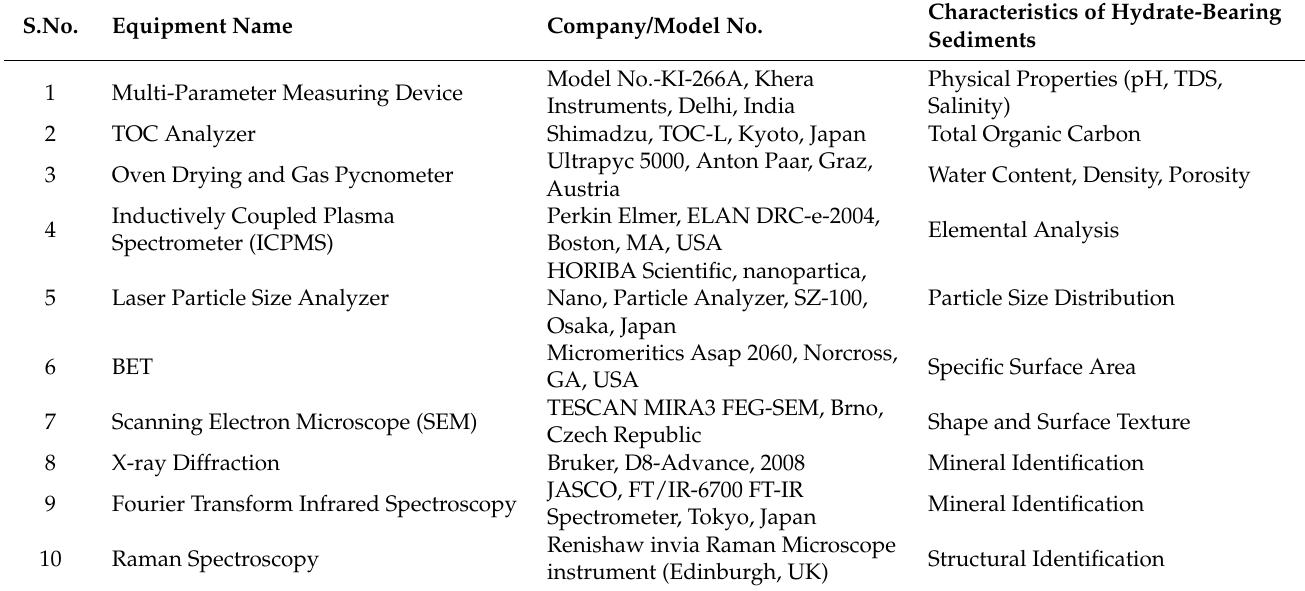
Table 1. Testing equipment used for different characteristics of hydrate-bearing sediments.